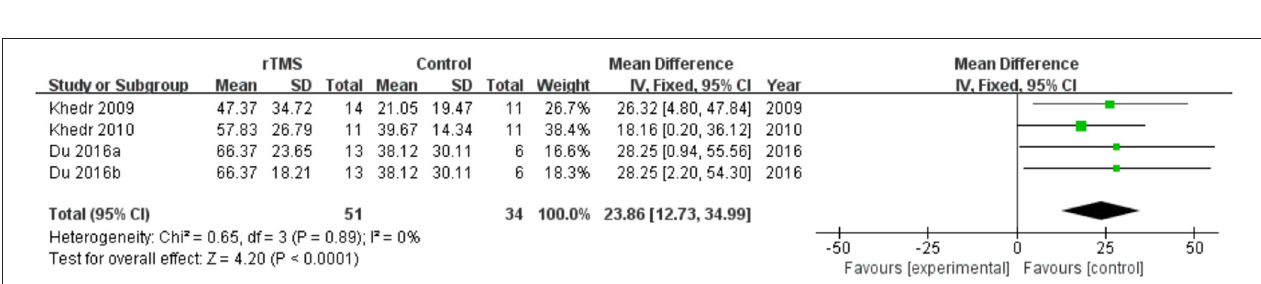
FIGURE 10 | Forest plot for subgroup analysis for Barthel index